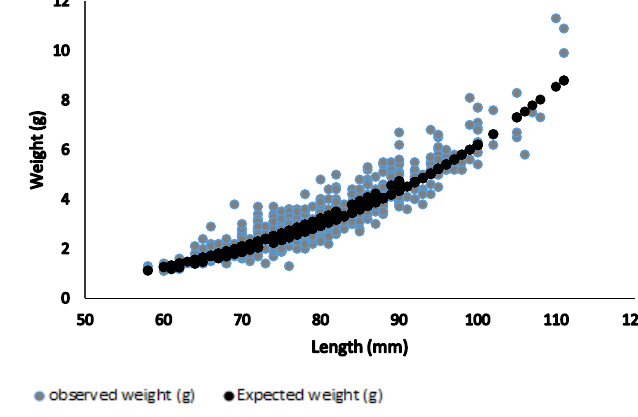
Fig. 5. Length/Weight relationship in pooled P. stylifera